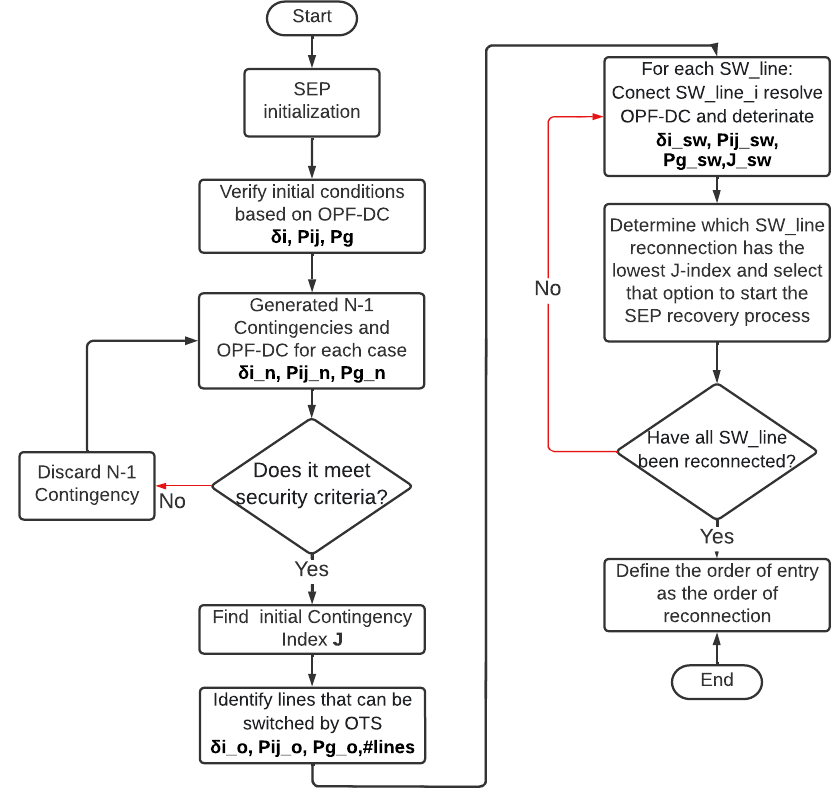
Figure 1. Flowchart for line